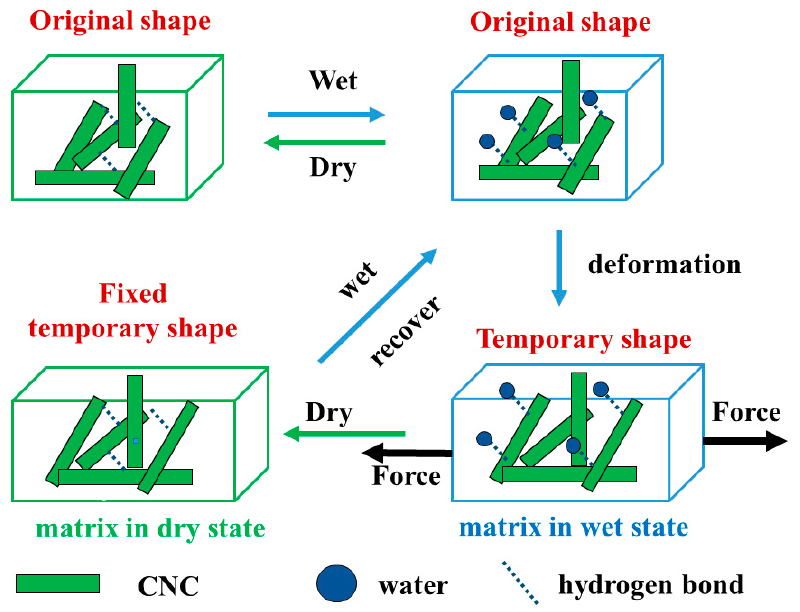
Figure Figure 12. Proposed rapidly switchable water-sensitive shape-memory mechanism for the TPU/CNCs comprising a CNC percolation network in an elastomeric matrix. Adapted from [187]. When the nanocellulose is introduced into the TPU matrix, a temporary network of hydrogen bonds between the nanocellulose (CNC or CNF) and the TPU is formed in the initial dry fi lm. When the composite swells in water, water molecules can di ff use into the fi lm, and competitive hydrogen bonds are formed between water molecules and hydroxyl groups of the nanocellulose, leading to the destruction of the temporary hydrogen bond network. In this state, the fi lm becomes soft («o ff ») and can be easily shaped by an external force. The material is then stretched to the desired deformed state and fi xed thanks to the rigid percolation network of nanocellulose created by the removal of water by drying